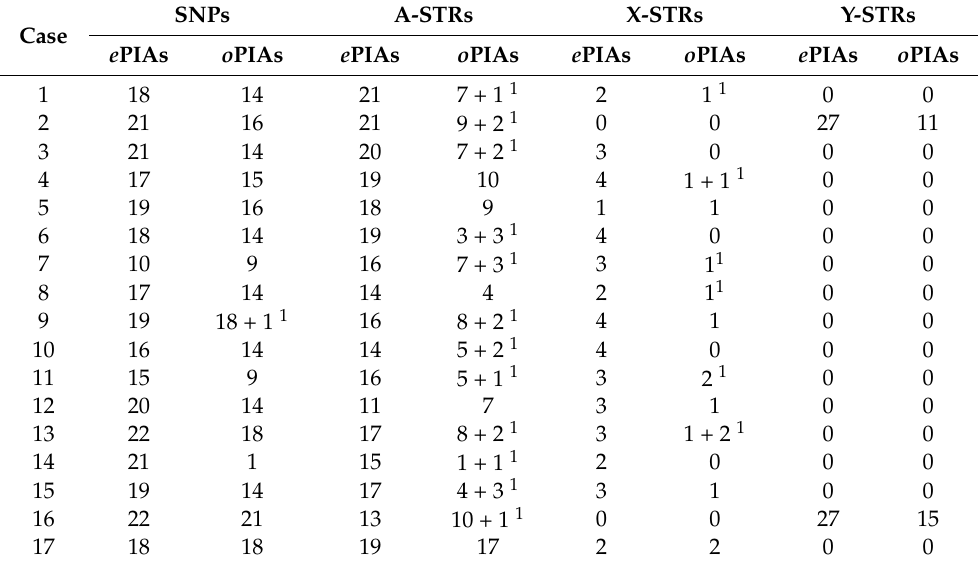
Table 1. Number of expected paternally inherited allele (e PIAs) and observed paternally inherited allele ( o PIAs) identified in maternal plasma